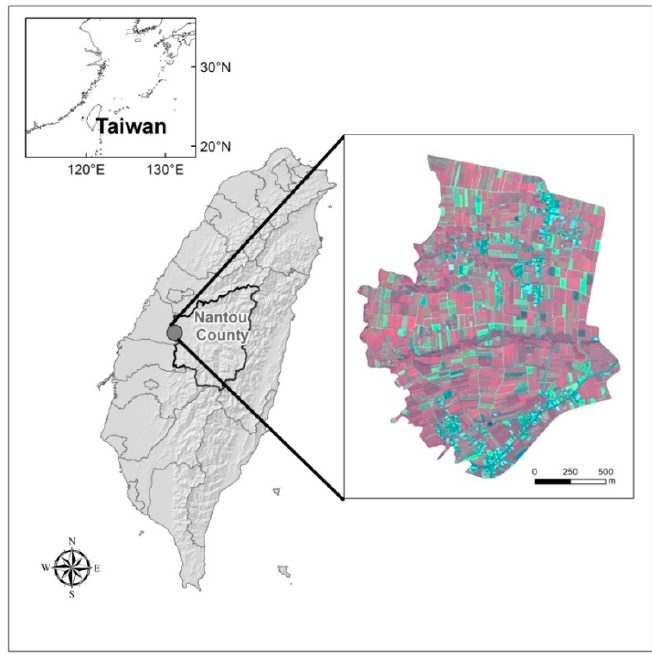
Figure 1. The location of study area in Nantou, Taiwan and the WorldView-2 imagery used to map tea cultivation area in this study.